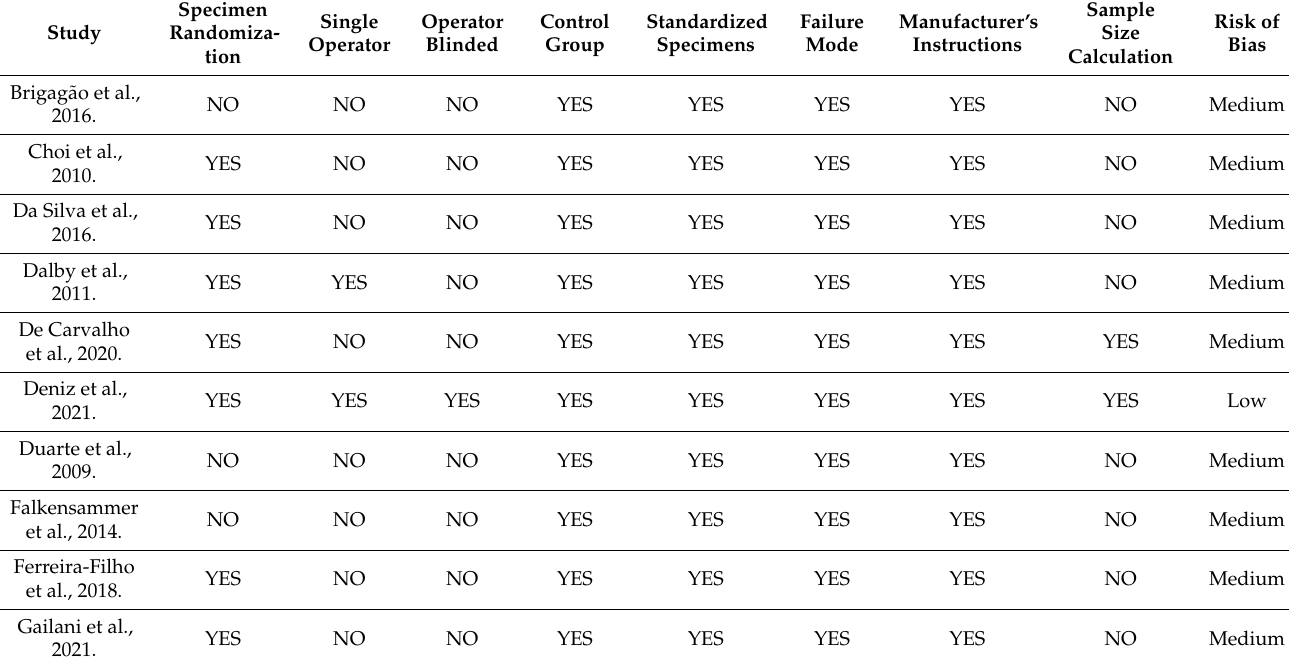
Table 2. Qualitative synthesis for in vitro articles.